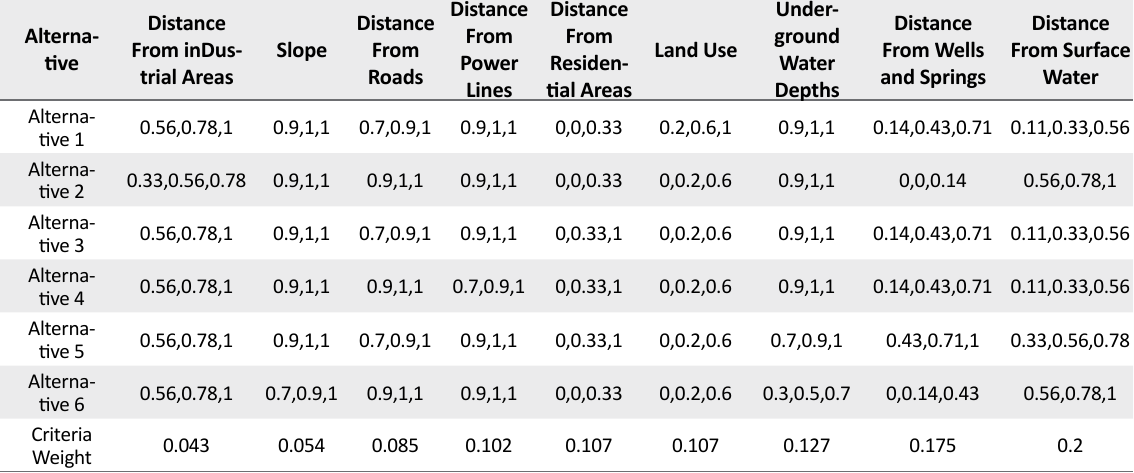
Table 8. Fuzzy TOPSIS normalized decision